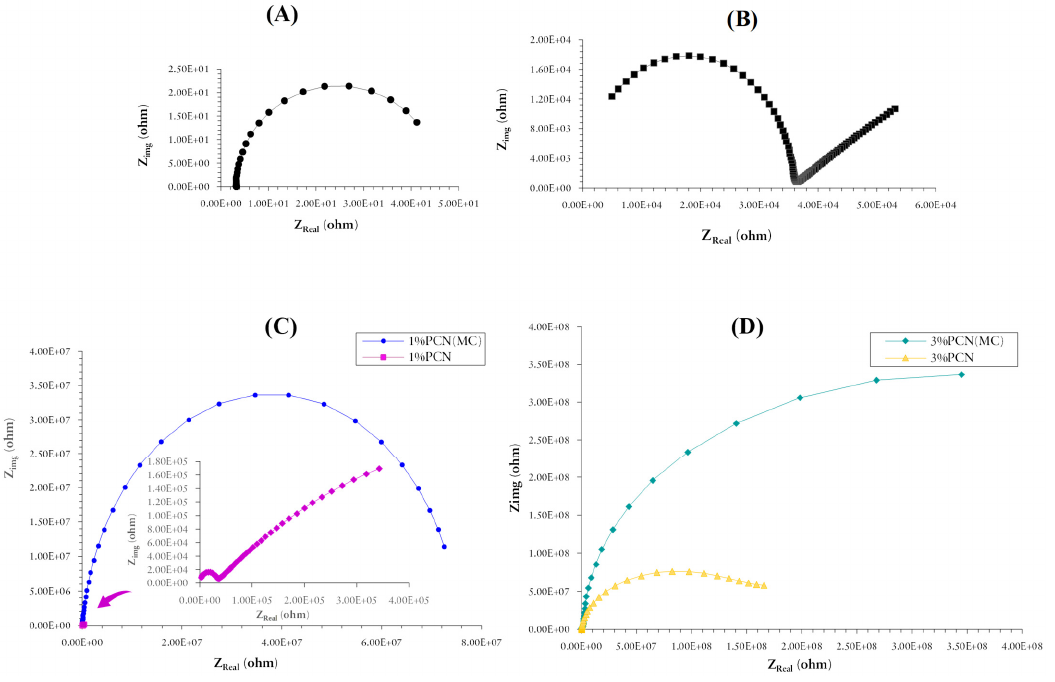
Figure 5. EIS Nyquist plots of ( A ) Bare C-steel, ( B ) PS, ( C ) 1 wt.% PCNs free and impregnated, and ( D ) 3 wt.% PCNs free and impregnated after 1 h of immersion in 3.5 wt.% NaCl at 20 ± 0.5 °C.